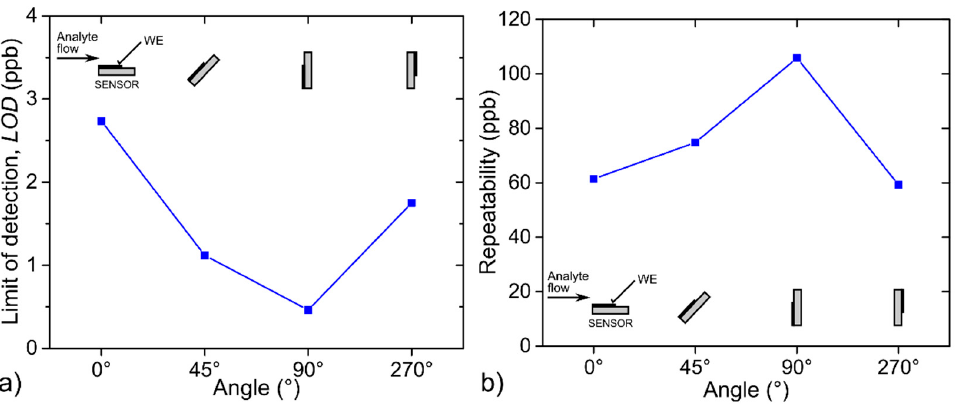
Figure 12. ( a ) LOD dependence on the mutual orientation of analyte flow direction and the WE surface area (22.4 mm 2 ); ( b ) repeatability dependence on mutual orientation of analyte flow direction and WE surface area (22.4 mm 2 ); conditions: 298 K, 40%RH, analyte flow rate 1